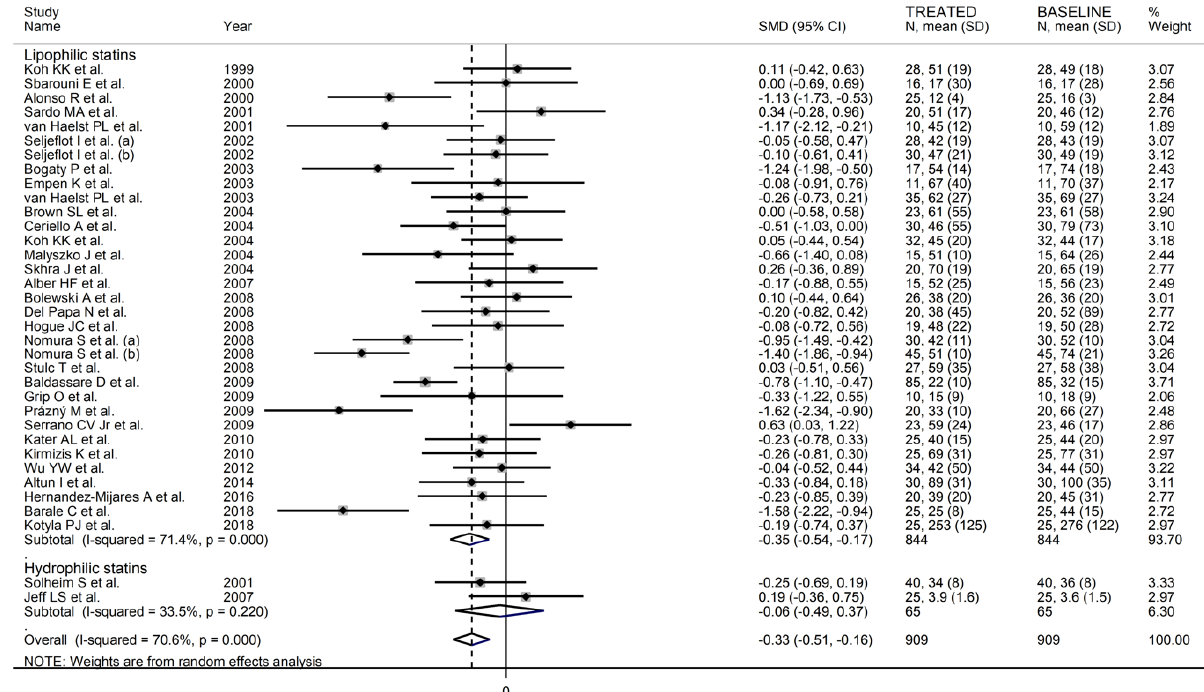
Figure 14. Forest plot of E-Selectin concentrations before and after statin treatment according to statin class (hydrophilic or lipophilic).